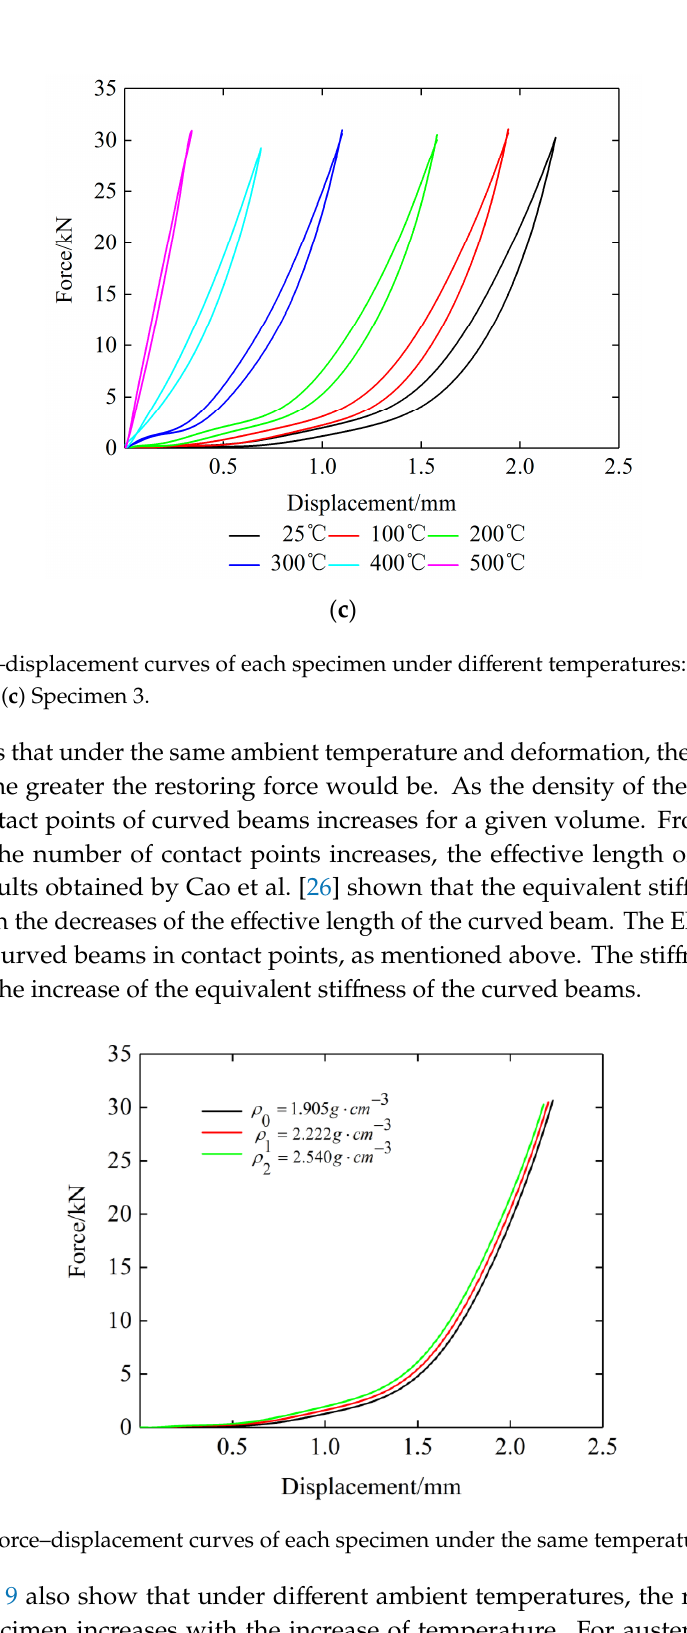
Figure 8. Force – displacement curves of each specimen under the same temperature (20 °C). Figure 8. Force–displacement curves of each specimen under the same temperature (20 ◦